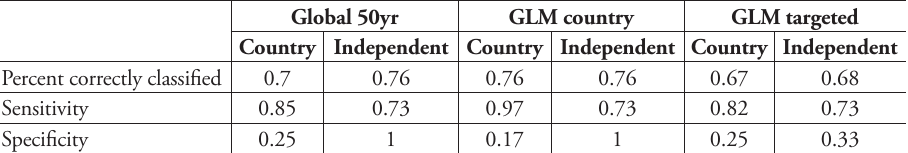
Table 2. Evaluation metrics for global extent models. Evaluation metrics include percent correctly clas- sified, sensitivity and specificity for global models of coypu ( Myocastor coypus [Molina, 1782]) habitat suitability (global 50yr: ecophysiological based model based using average monthly temperature for 1950 to 2000, generalized linear model [GLM] country: GLM model using coypu presence locations and ran- dom background locations from countries containing coypu locations, and GLM targeted: GLM model using coypu presence locations and targeted background consisting of muskrat locations), evaluated using country level classification according to Carter and Leonard (2002; ‘country’ columns) and independent coypu location data (‘independent’